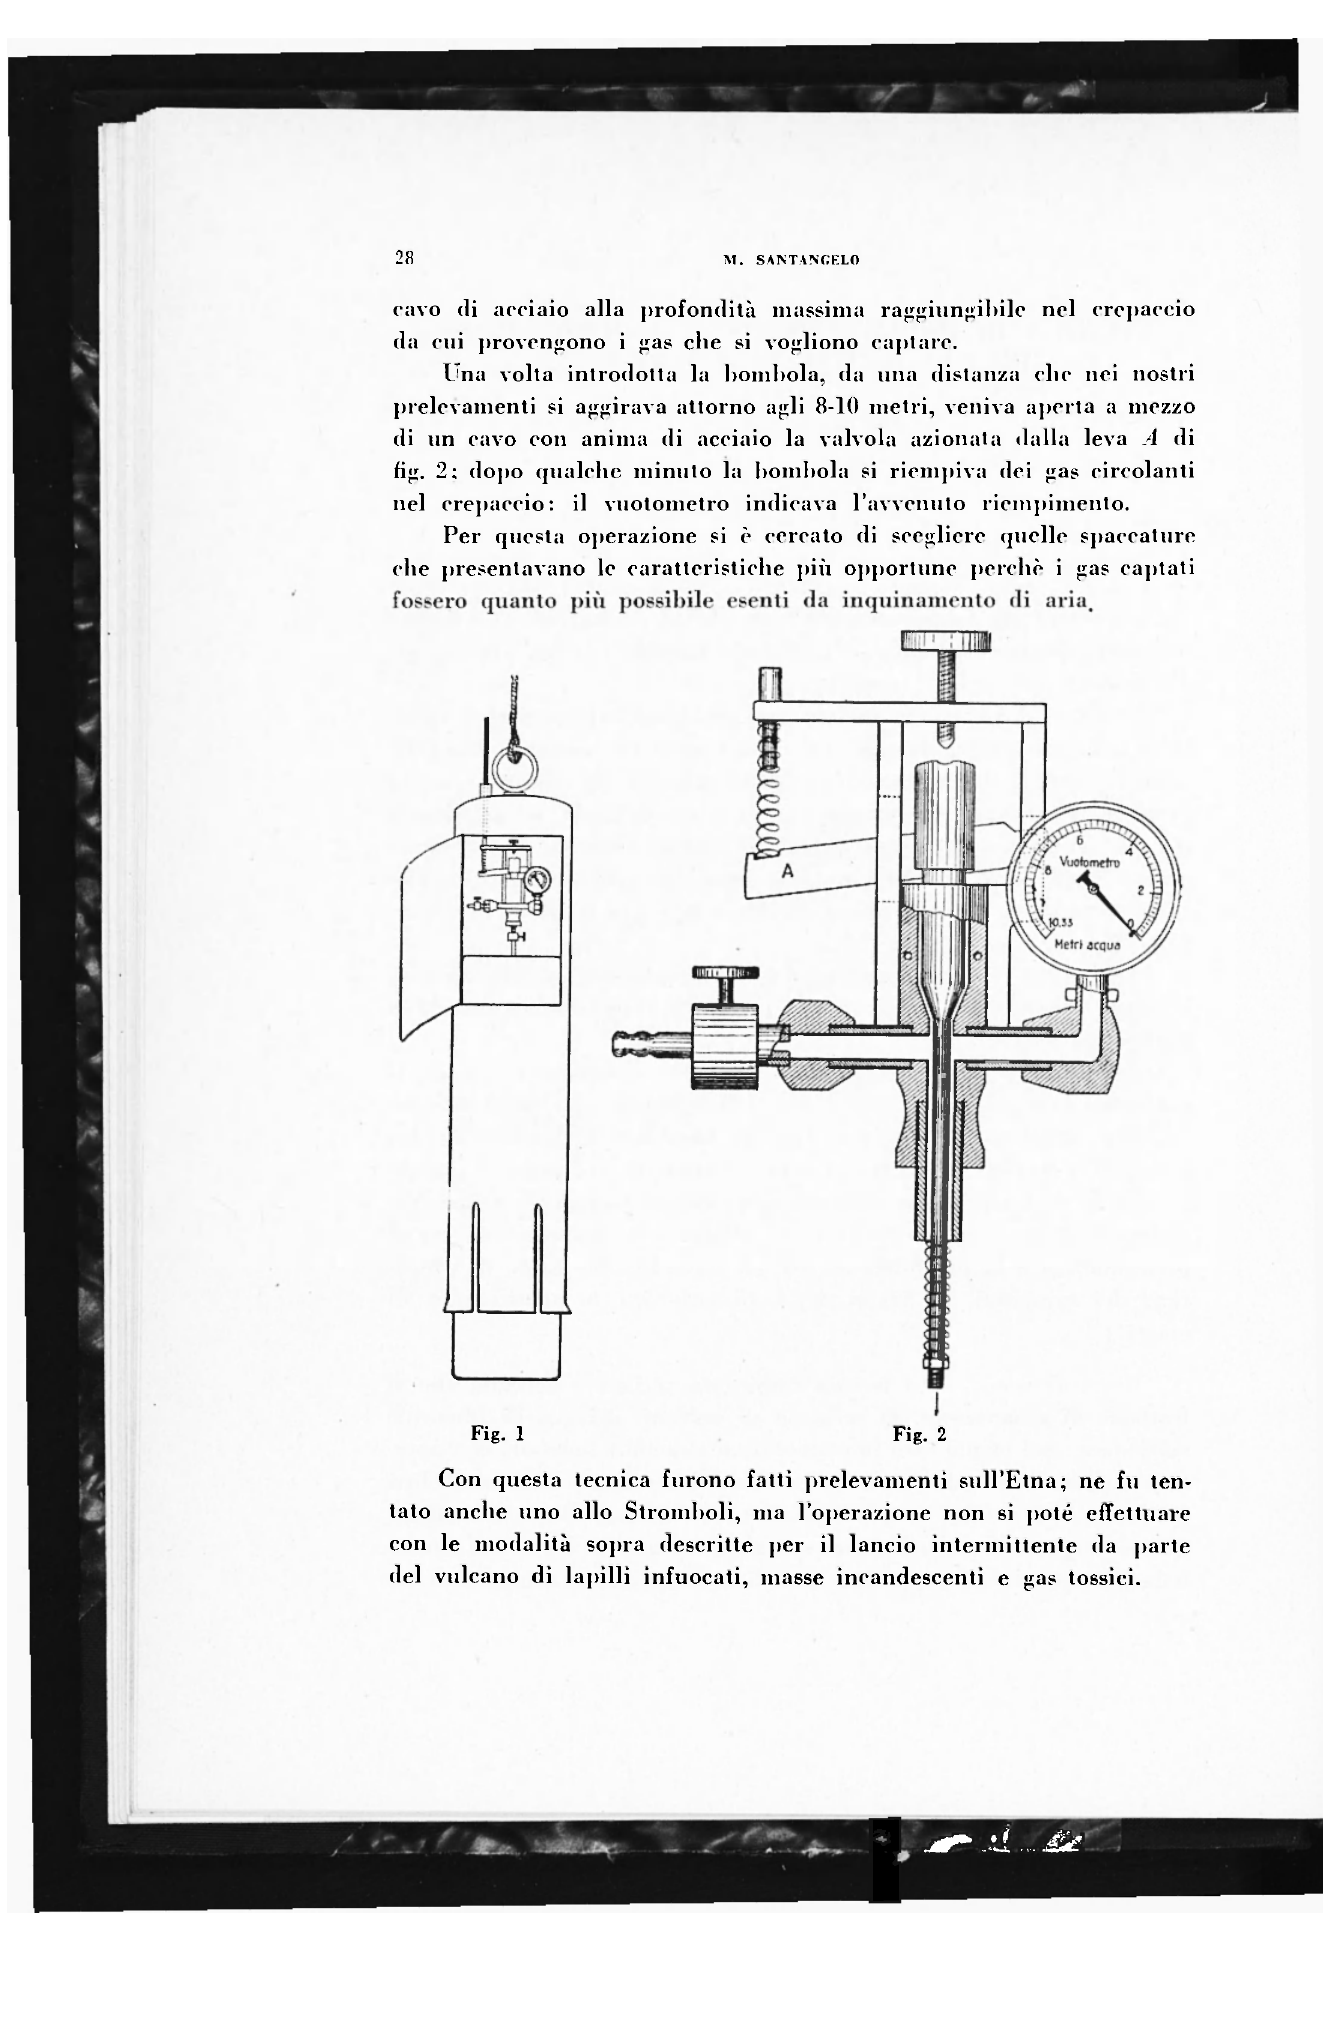
fig. 2: dopo qualche minuto la bombola si riempiva dei gas circolanti nel crepaccio: il vuotometro indicava l'avvenuto